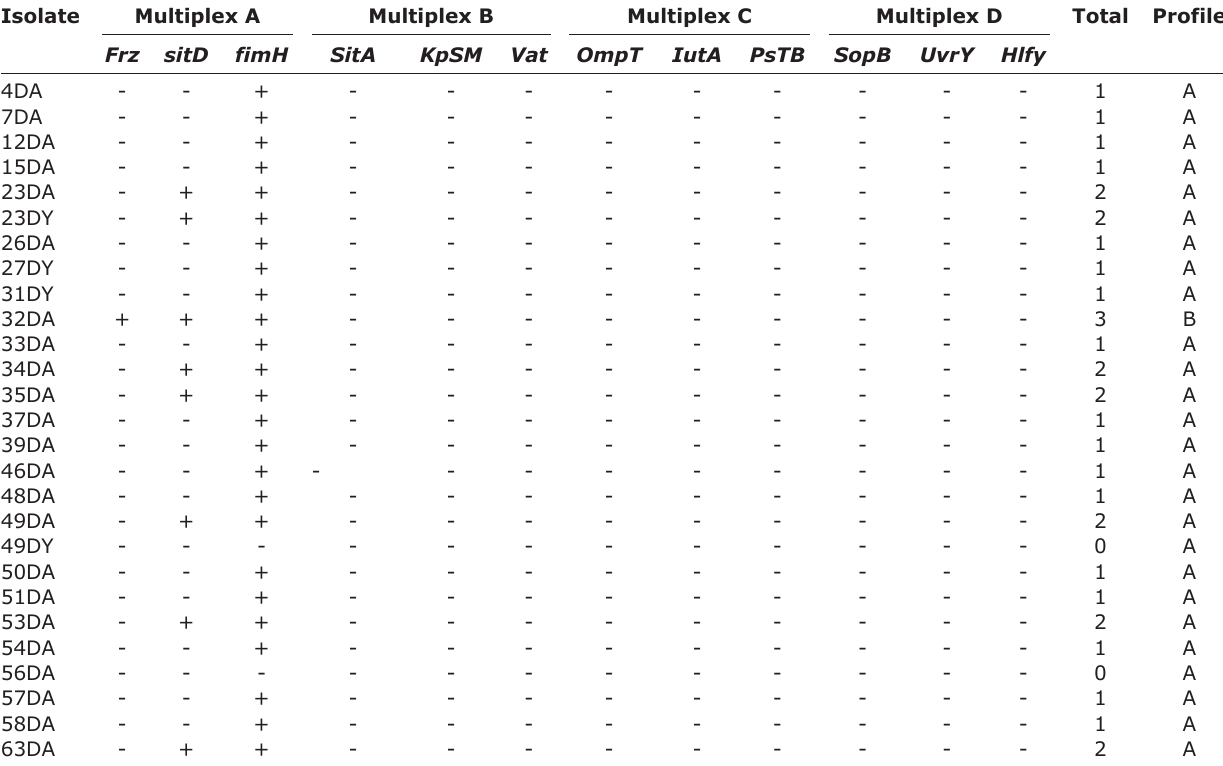
Table-3: Virulence genes detected in AFEC from ducks. Isolate